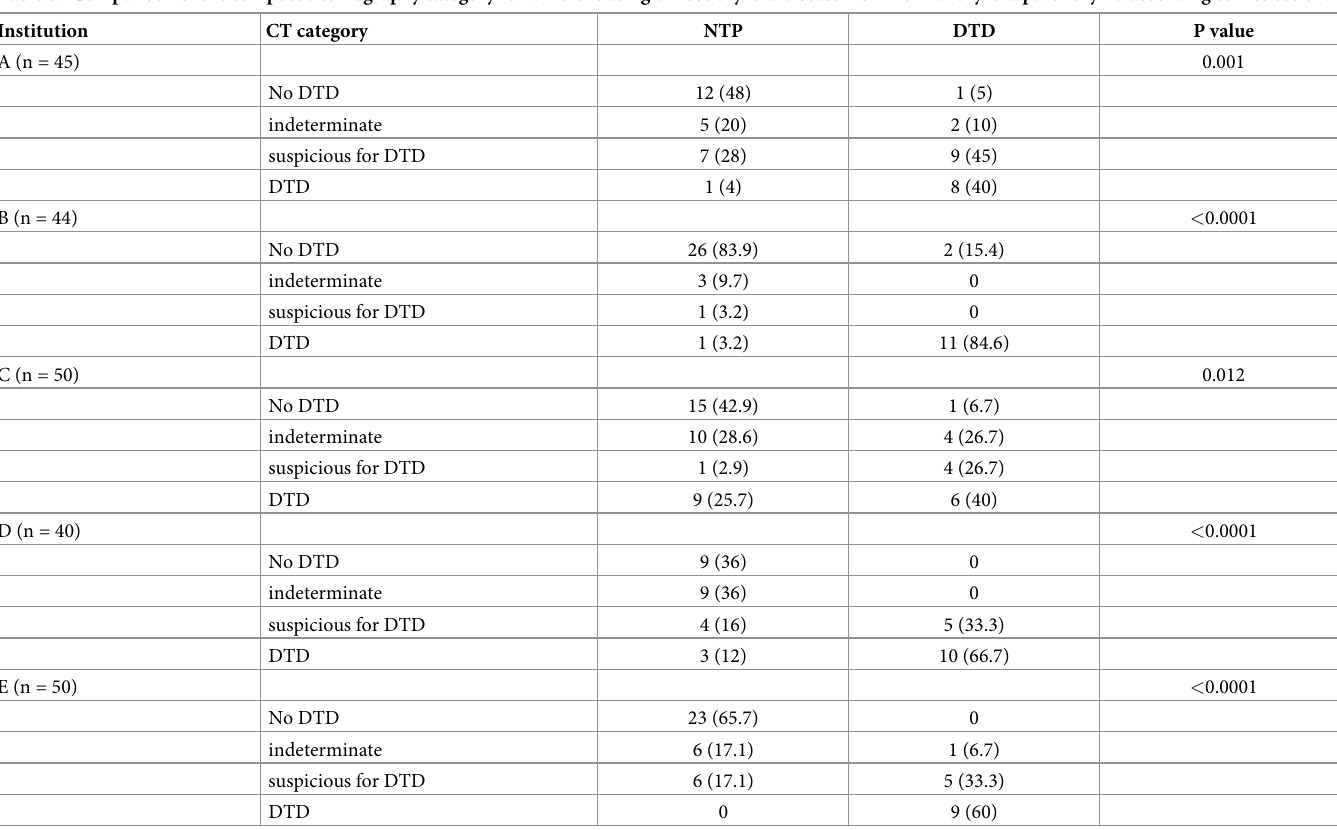
Table 5. Comparison of the computed tomography category for differentiating diffuse thyroid disease from normal thyroid parenchyma according to institution.